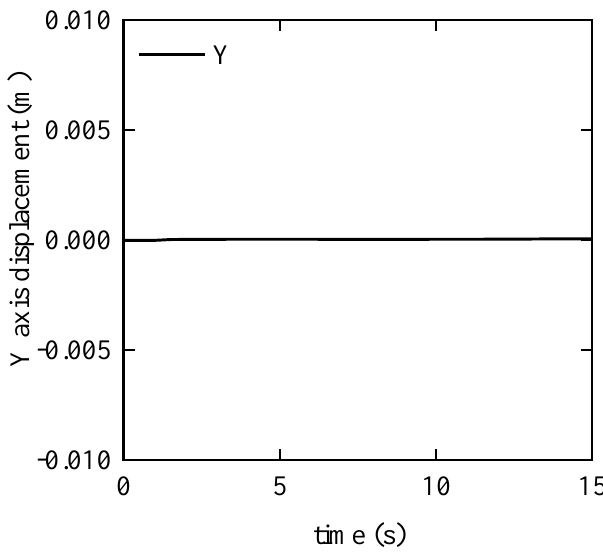
Figure 5. Displacement in the Y -axis direction.